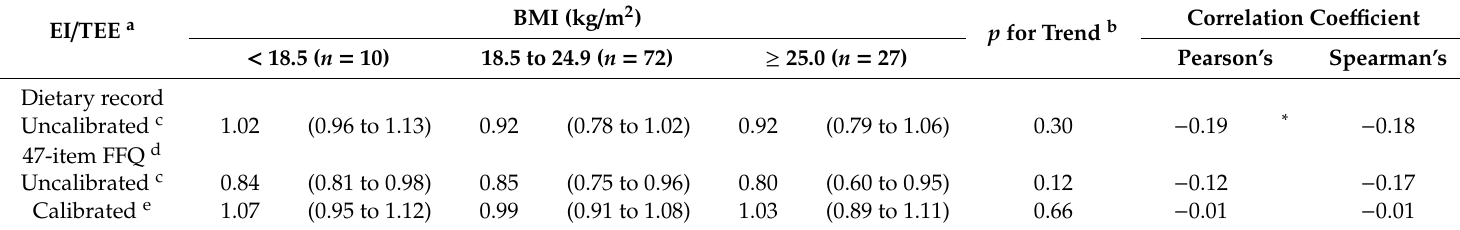
Table 6. Comparison of the ratio of energy intake to total energy expenditure according to body mass index